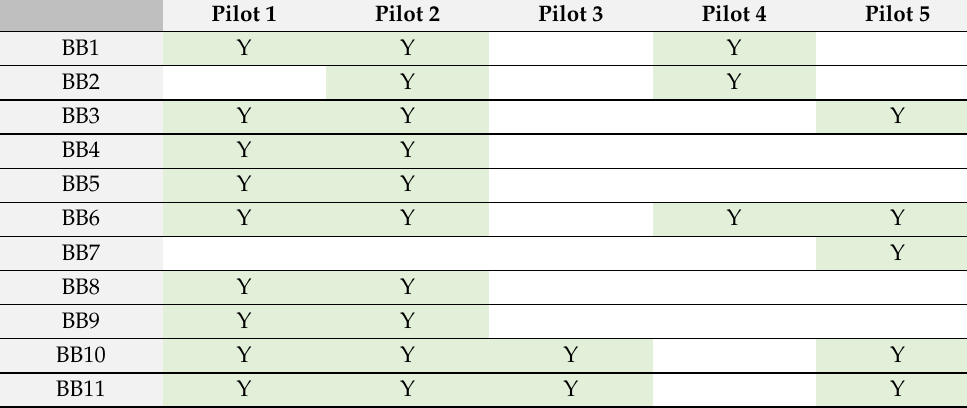
Table 1. BB implementation on selected pilots. Y—BB was